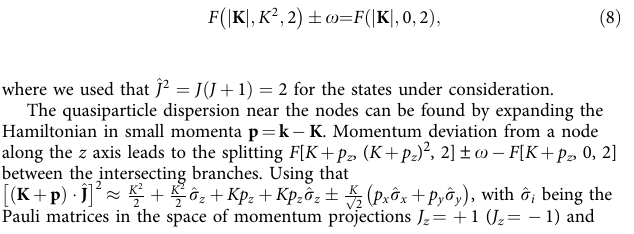
Methods Dispersion near Weyl nodes . In this work, we define the quasiparticle dispersion as the poles of the retarded Green’s function averaged with respect to quenched disorder. While long-wave quasiparticles ( k - 0) are insensitive to the details of the lattice potential, their effective Hamiltonian preserves rotation and inversion symmetries, and in the absence of magnetic field– time-reversal symmetry, with the generic form of the Hamiltonian given by equation (1) and with the vector x parallel to the magnetic field. We assume the existence of excitations with momentum J ¼ 1 and focus on the respective manifold of states in what follows. The dispersion of such excitations has three branches for each momentum k . For momenta k parallel to x the respective excitations have momentum projections J z ¼ 0 and J z ¼ ± 1 on the direction x . The branch with J z ¼ 0 intersects the branch with J z ¼ ± 1 at momenta K || o such that